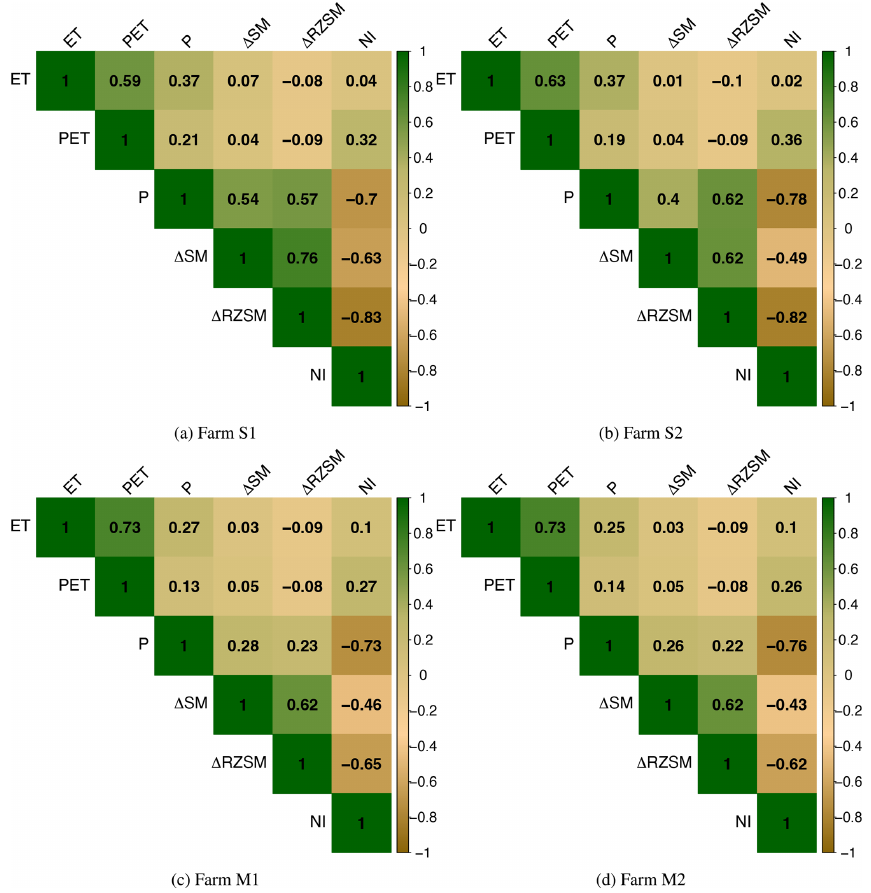
Figure 4. Pearson correlation relationship between observed 8d ET (mm per 8d), PET (mm per 8d), P (mm per 8d), (cid:49) SM (m 3 m − 3 ), (cid:49) RZSM (m 3 m − 3 ), and NI (mm per 8d) for farms S1, S2, M1, and M2 during agricultural years (2015–2020). Significance level of 99%.